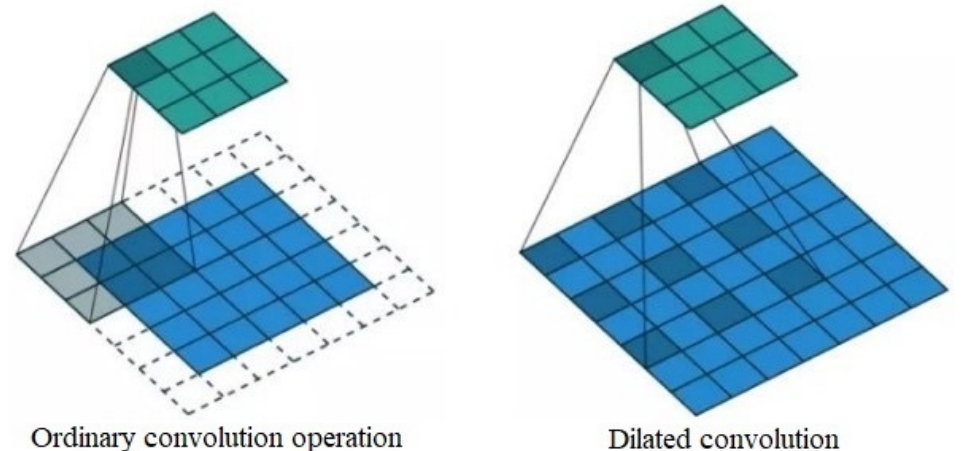
Figure 4. Comparison of CNN and TCN convolution.